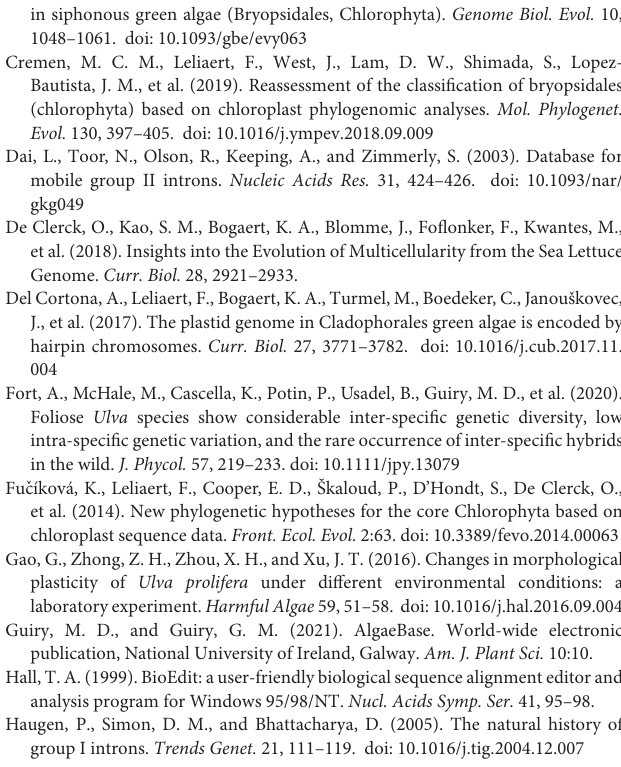
Supplementary Figure 1 | Phylogenetic tree based on Maximum Likelihood (ML) analysis of amino acid (aa) sequences of 139 LAGLIDADG endonuclease domain regions (64 in cpDNAs and 75 in mtDNAs) from five types of introns including group IB (complete), group IA3, group I (derived, B2), group ID, and group II (LHE). Different colored lines denoted LAGLIDADG endonuclease domains from different groups of introns: group IB (complete), blue; group IA3, brown; group I (derived, B2), cyan; group ID, green; and group II (LHE), pink. The ML analysis was conducted with 1,000 bootstrap replicates using MEGA 7.0. The bootstrap support values greater than 80% were displayed at branches. Branch lengths were proportional to the amount of sequence change, which were indicated by the scale bar below the trees. Supplementary Figure 2 | Phylogenetic tree based on Maximum Likelihood (ML) analysis of amino acid (aa) sequences of 67 reverse transcriptase (RT) domains (40 in cpDNAs and 27 in mtDNAs) from group IIA and IIB introns. The ML analysis was conducted with 1,000 bootstrap replicates using MEGA 7.0. The bootstrap support values greater than 80% were displayed at branches. Branch lengths were proportional to the amount of sequence change, which were indicated